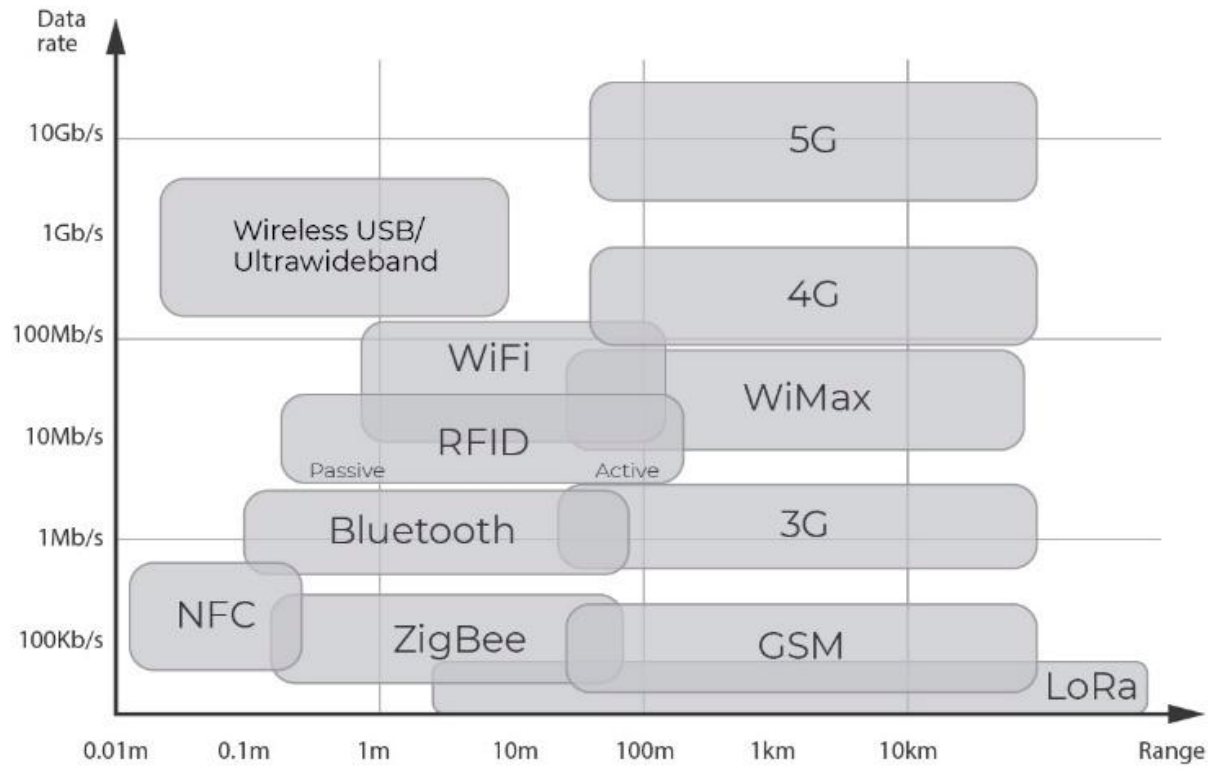
Figure 11. Data rate vs. range of data transmission for different communication protocols.